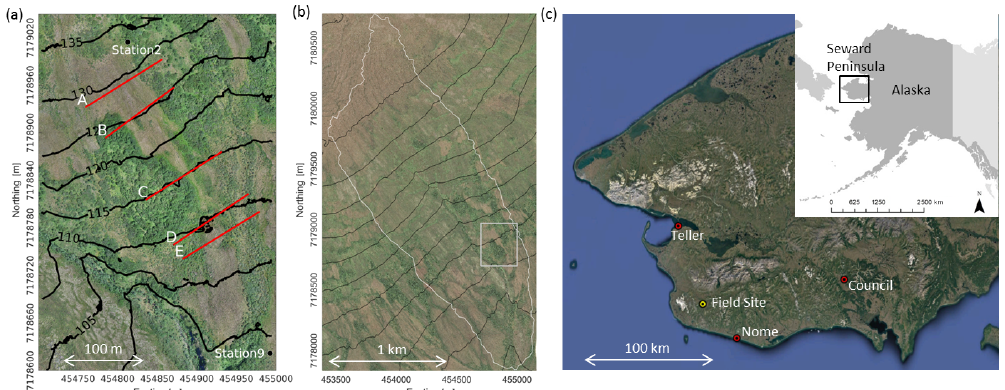
Figure 1. Location and general setting of the study area. (a) Aerial view of the investigated site, which includes a hillslope and a flatter toe area. Tall shrubs are dark green, mosses are bright green, and graminoids and dwarf-shrub-dominated areas are light brown. The RGB mosaic is overlain with the location of the two long-term monitoring stations in this area, the location of transects surveyed in this study, and topographic isoline for every 5m of elevation (in ma.m.s.l.). (b) Location of the investigated site (grey rectangle) in the Teller watershed (white line). Topographic isoline for every 20m of elevation. (c) Location of the investigated field site on the southern Seward Peninsula in Alaska (© Google